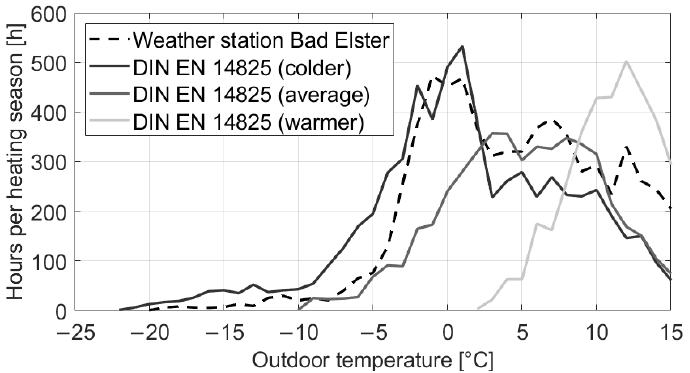
Figure 2. Outdoor temperature distribution of the DWD weather station Bad Elster from 28